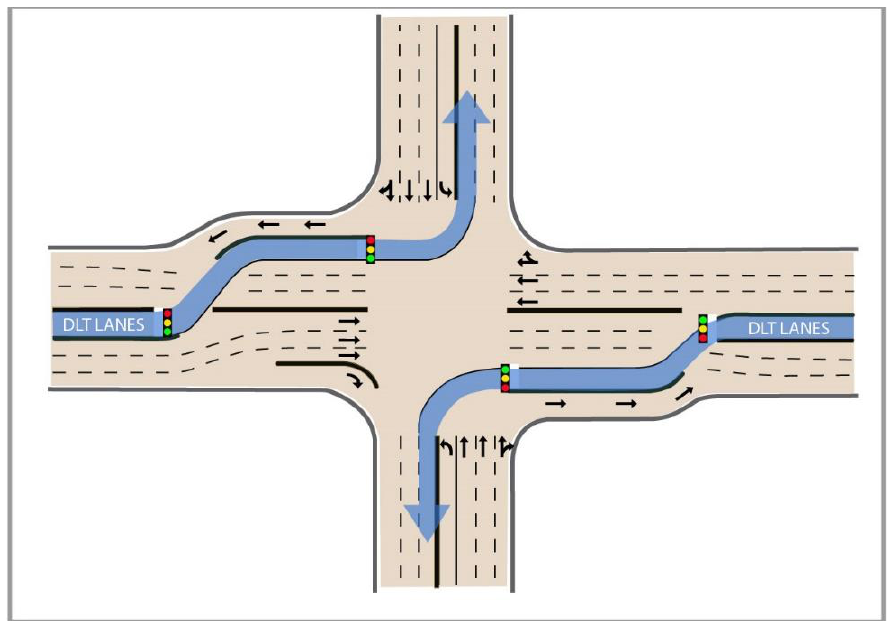
Figure 1. Displaced left-turn (DLT) layout (partial DLT with two crossovers).